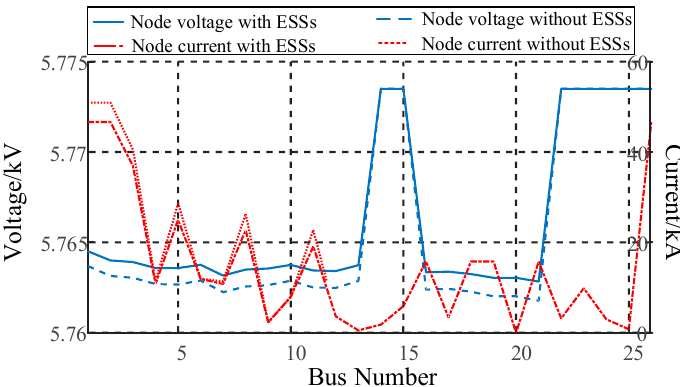
Figure 10. The voltage and current amplitude of each node.